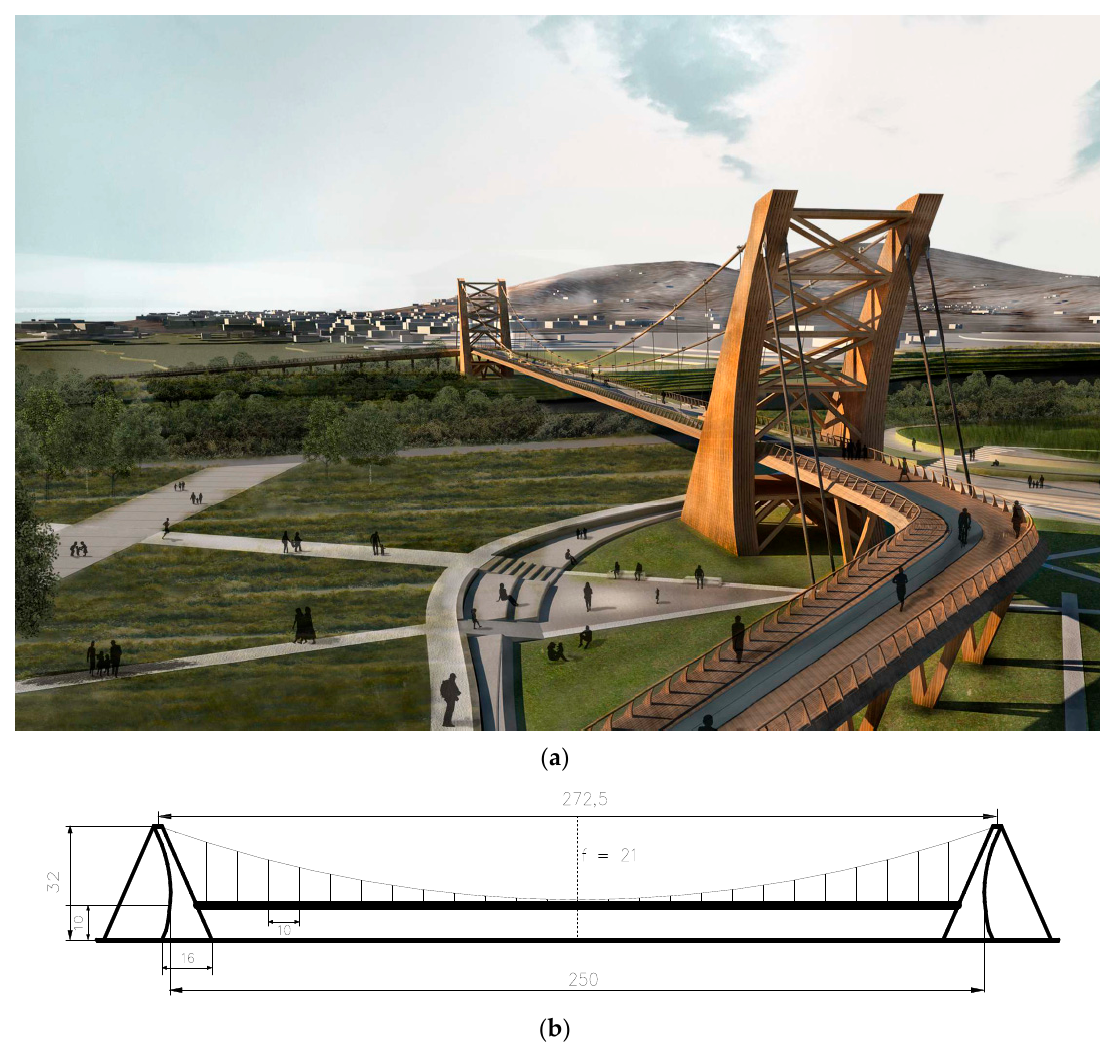
Figure 7. Pedestrian bridge virtual photograph ( a ) and longitudinal view ( b ).